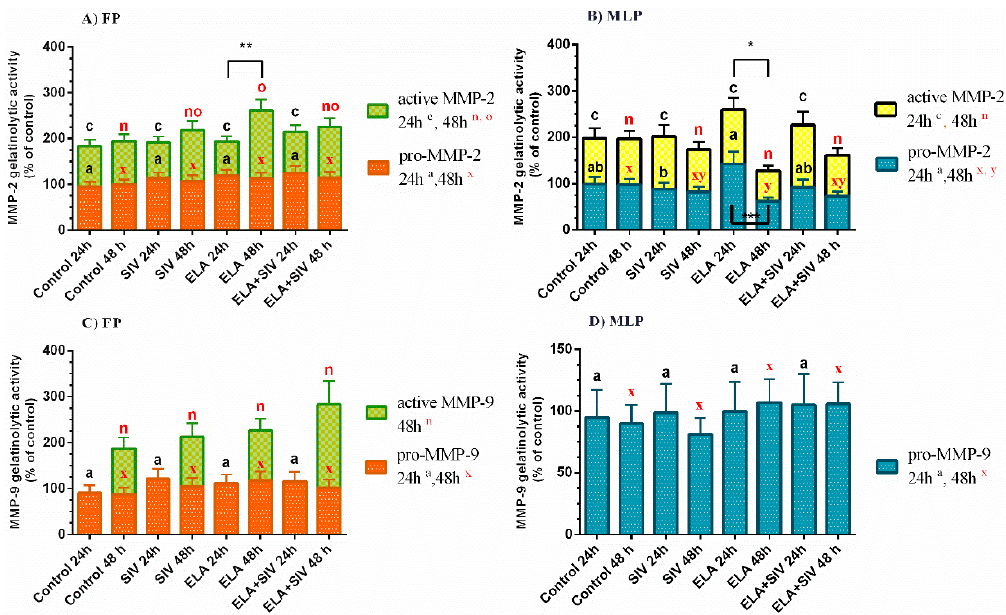
Figure 3. Relative gelatinolytic activities of MMP-2 ( A , B ) and MMP-9 ( C , D ) in follicular phase (FP) and mid-luteal phase (MLP) mare endometrial explants treated for 24 or 48 h with medium alone (control), elastase (ELA: 0.5 µg/mL), sivelestat (SIV: 10 µg/mL), or ELA (0.5 µg/mL) + SIV (10 µg/mL). All values are expressed as percentage of change from control (non-treated tissues). Bars represent least square means ± SEM and results were considered significant at p < 0.05. Different superscript letters indicate significant differences between treatments within each of treatment time. Asterisks indicate statistical differences between different treatment times for the same treatment, and for the same form of MMP (* p < 0.05; ** p < 0.01; *** p < 0.001).